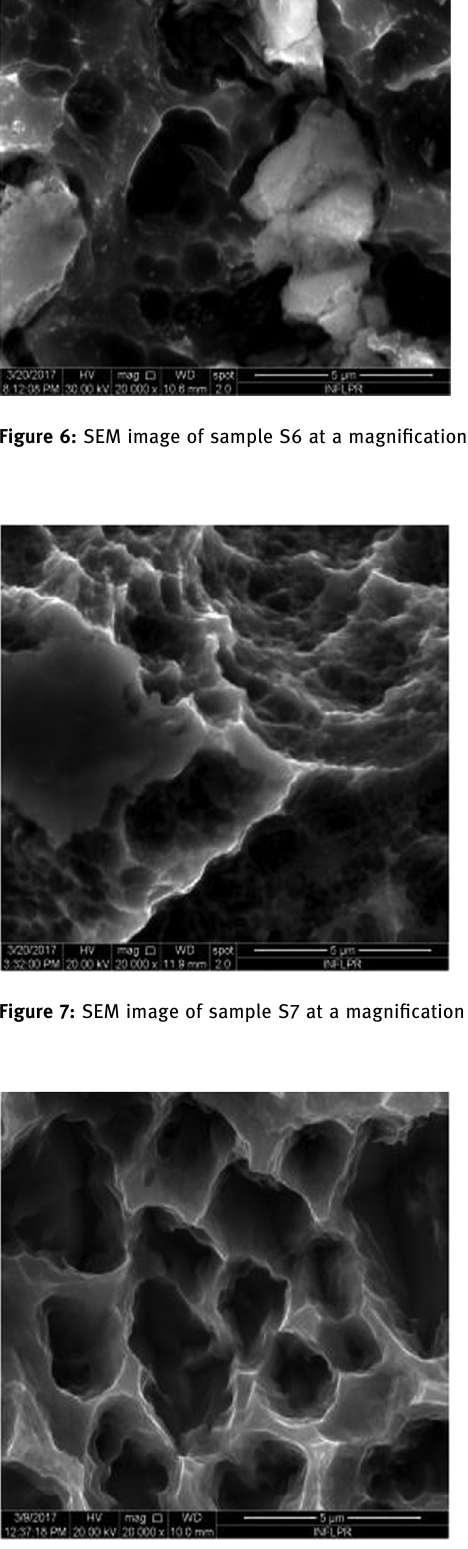
Figure 10: SEM image of sample S10 at a magni fi cation of 5k ×